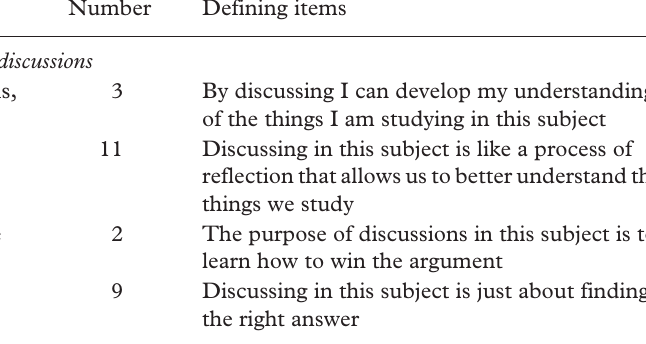
Table 1. Scales of the questionnaires used in this study, defining items and internal consistency reliabilities Scale Number Defining items Conceptions of learning through